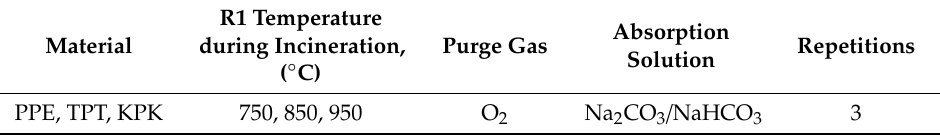
Table 4. Experimental conditions—incineration experiments.